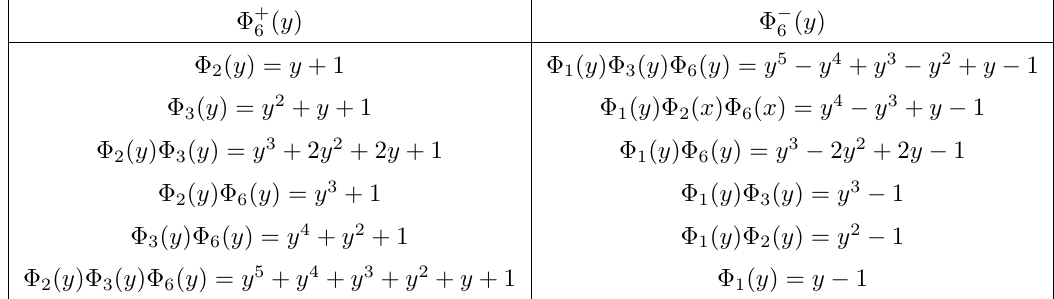
Table 1 . The possible products of cyclotomic polynomials with all coe(cid:14)cients positive (cid:8) + the corresponding antipalindromic polynomials (cid:8) (cid:0)